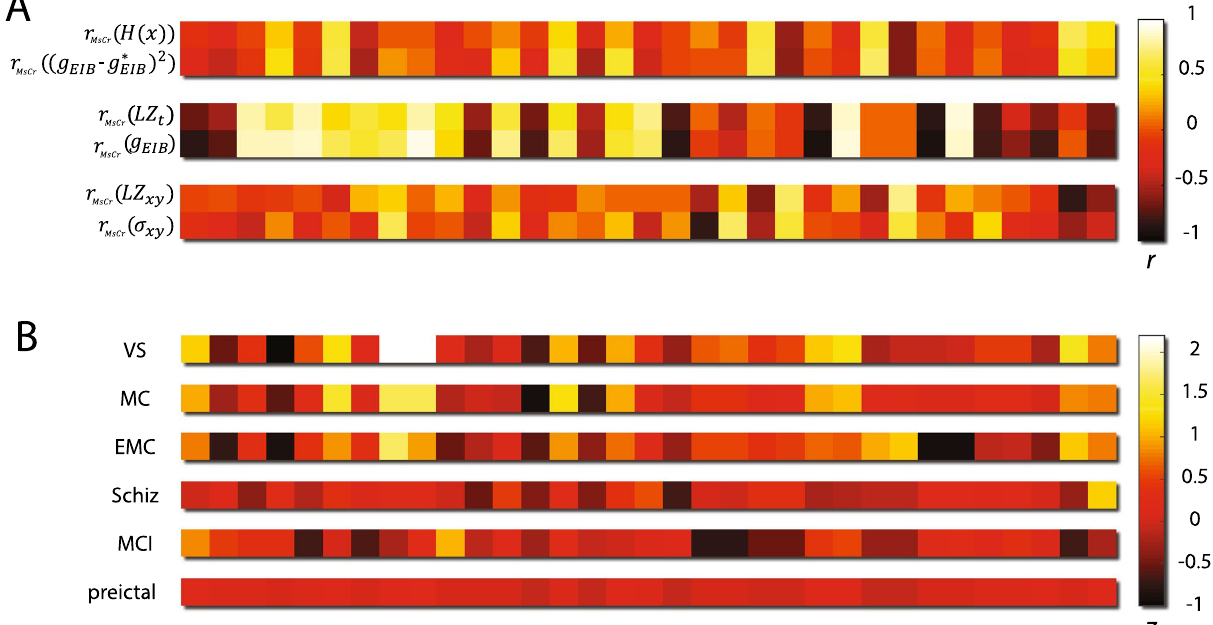
Figure 5. MsCr fingerprints characterize information processing states of the brain. ( A ) the correspondence between patterns of MsCr correlation to network control parameters, and patterns of correlation between MsCr measures and information measures, in a simulation of a generic cortical network described in 20 . Each horizontal color bar corresponds to a correlation pattern between the 33 MsCr measures used in this study and a variable of interest. The patterns are color coded according to the strength of correlation. r MsCr ( x ) denotes the correlation of x to MsCr measures across various realizations of the simulated architecture. g EIB is the ∗ parameter controlling EIB (its increase increases excitation relative to inhibition), g EIB is a numerically derived intermediate value in which informational measures are maximized. σ xy is the parameter used in the simulation to control the spatial extent of connectivity. H(x) denotes activity pattern entropy. LZt and LZxy denote Lempel– ziv temporal and spatial complexity respectively. The correlation between pairs of patterns from top to bottom is 0.95, 0.99 and 0.75 respectively. ( B ) MsCr fingerprints of compromised informational states of the brain. Magnitude is expressed in z scores relative to the MsCr fingerprint of matched controls. Note that none of the 33 measures exhibits the same relation to the norm (e.g. exceedingly high) across all 6 experimental conditions (see also Fig. 4, and Supplementary Tables